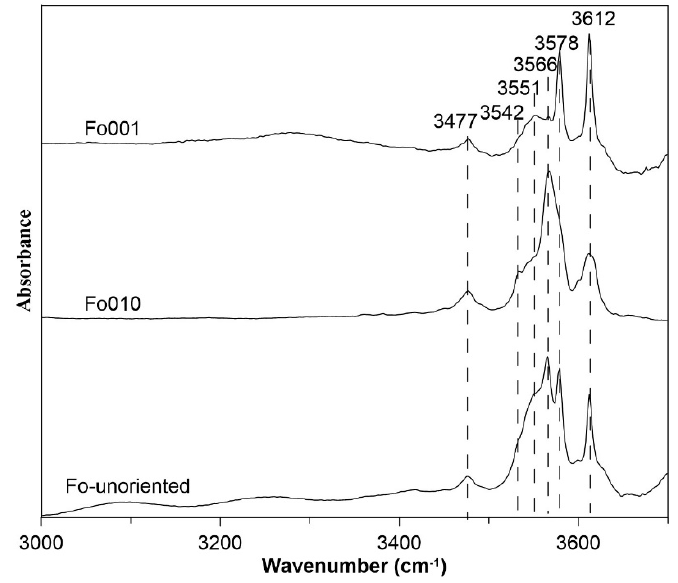
Figure 1. The unpolarized Fourier Transform infrared (FTIR) spectra measured for the hydrous forsterite samples at ambient condition, with the peak positions labeled.